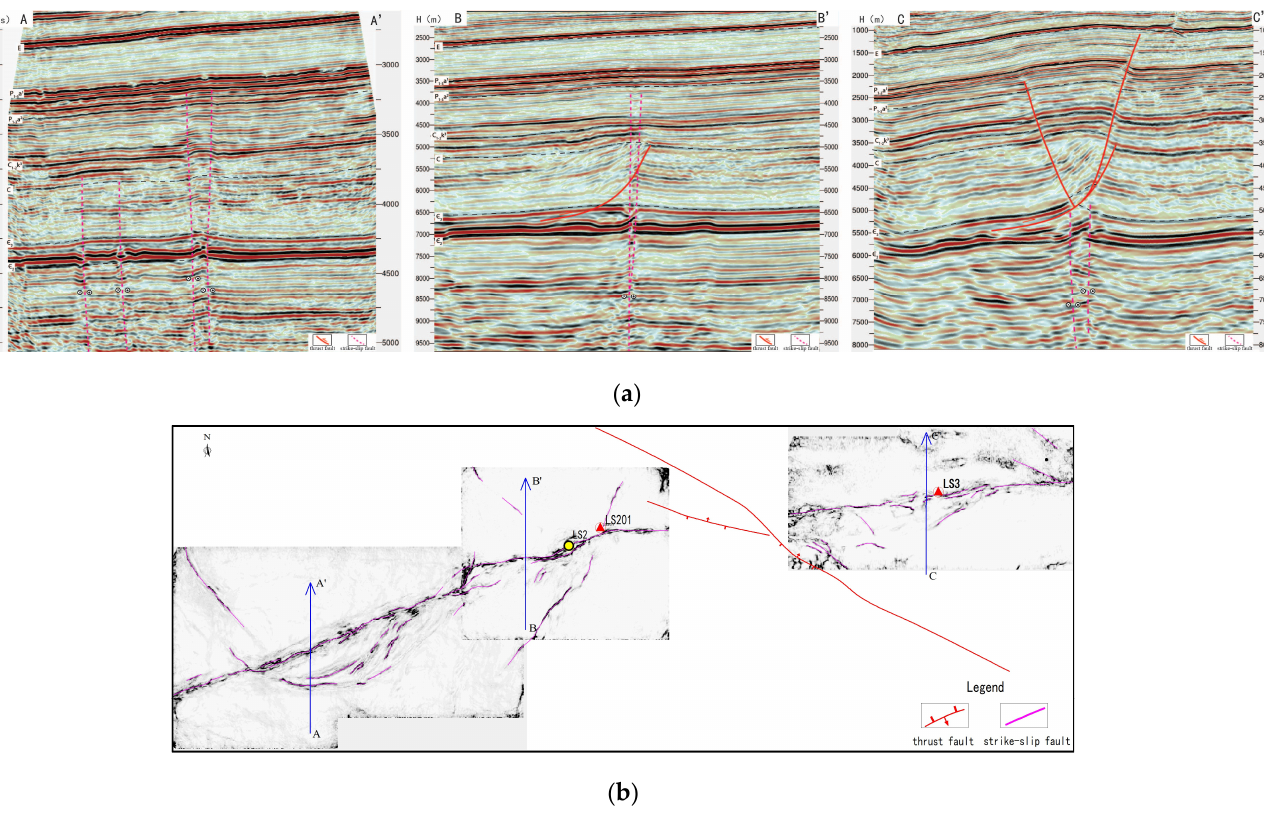
Figure 5. Characteristics of strike-slip fault in middle of Maigaiti Slope. ( a ) Characteristics of strike- slip fault profiles in middle of Maigaiti Slope. ( b ) Middle Cambrian bottom coherence of strike-slip fault about 3D seismic data in middle of Maigaiti Slope.